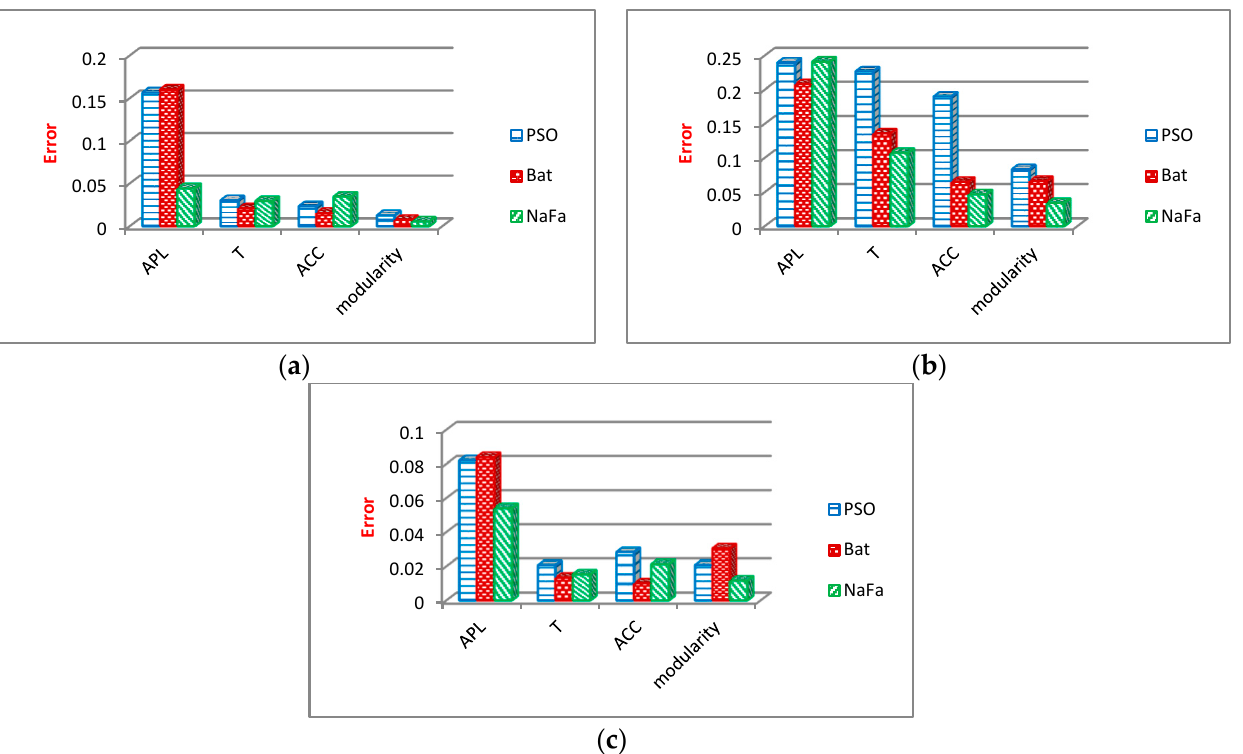
netscience, and ( c ) power grid . Figure 18. Average of error values of the algorithms for different values of L on ( a ) Dolphins,